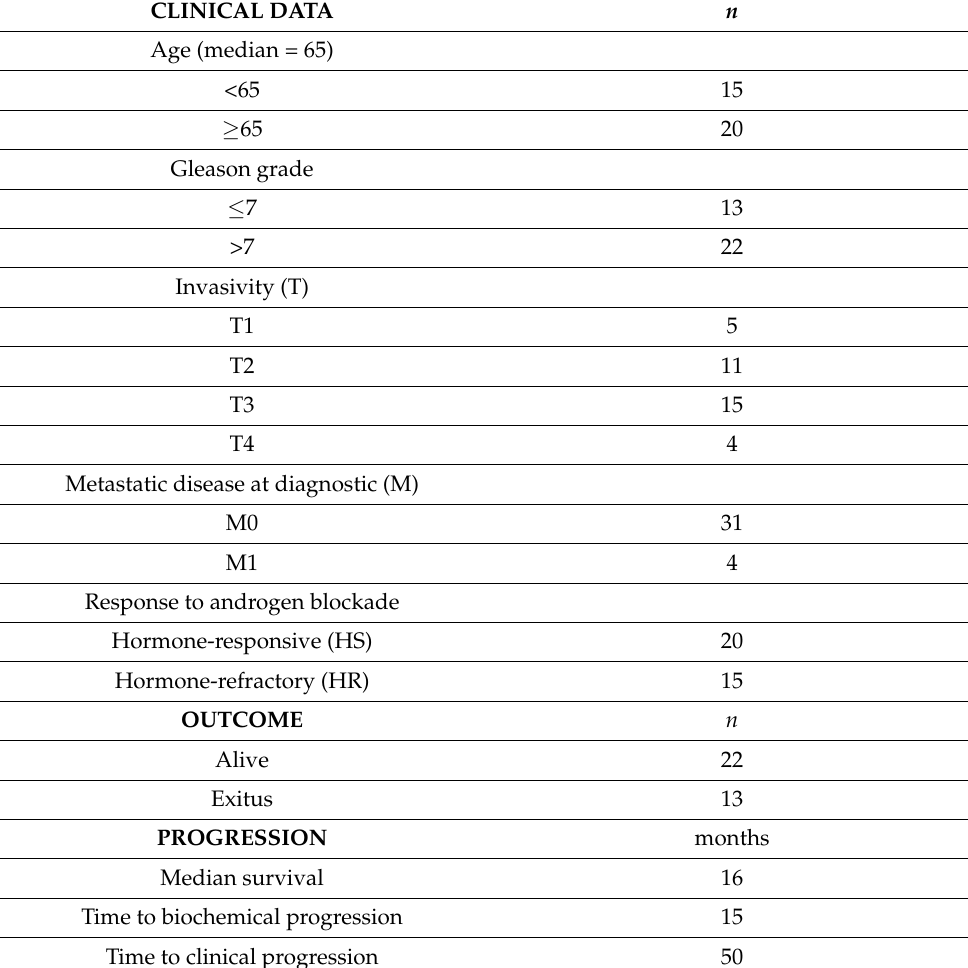
Table 1. Clinical data of prostate cancer patients ( n =